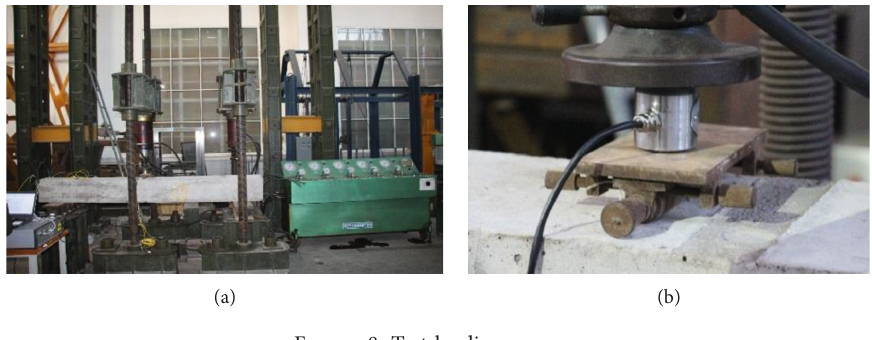
Figure 8: Test loading